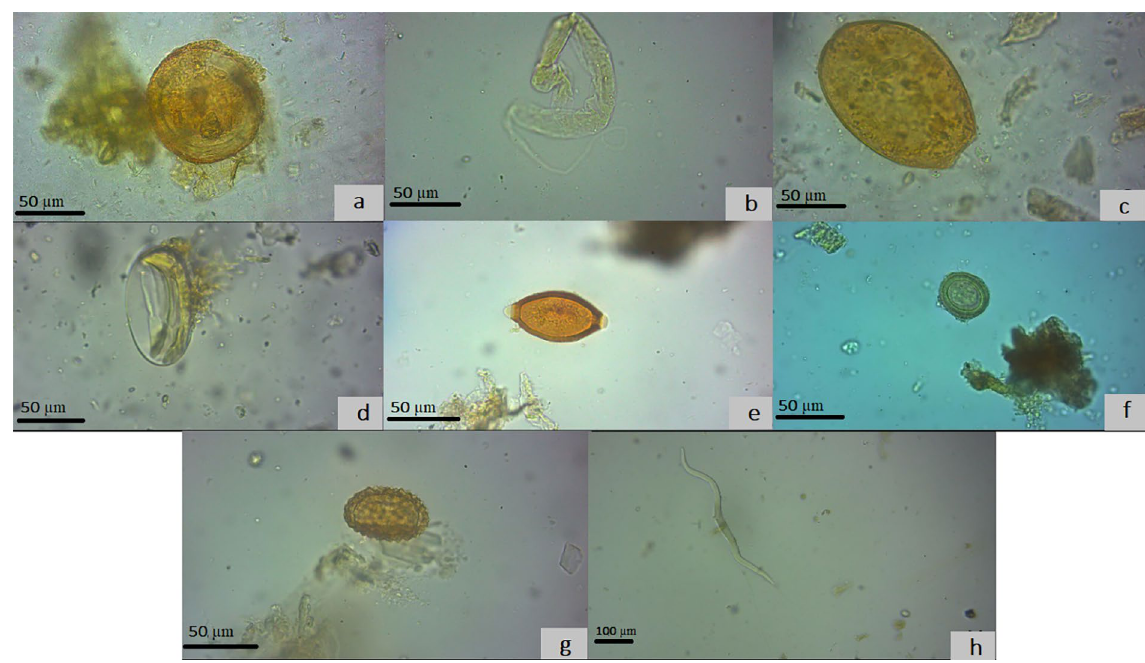
Figure 2. The microscopic results: From top left to right: ( a ): Parascaris sp. egg, ( b ): Strongyle larvae, ( c ): Fasciola sp. egg, ( d ): Strongyle egg, ( e ): Trichuris spp. egg, ( f ): Taenia spp. egg, ( g ): Ascaris sp. egg, and ( h ): unknown nematode larvae. Edited by Microsoft paint, version 21 H2, https:// www. micro soft. com/ en- us/ windo